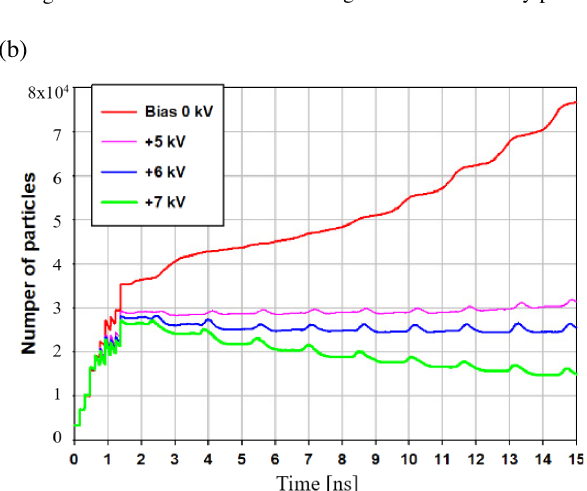
FIG. 18. (a) Vacuum side coupler sections analyzed for multi- pacting and (b) representative observation of multipacting and mitigation by applying dc bias. A similar plot is obtained for each section but not shown here to avoid